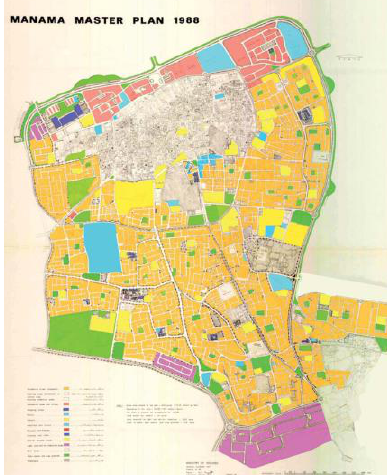
Figure 9: Implementation of Manama Master Plan 1988 (Al-Nabi, The History of Land use and Development in Bahrain,